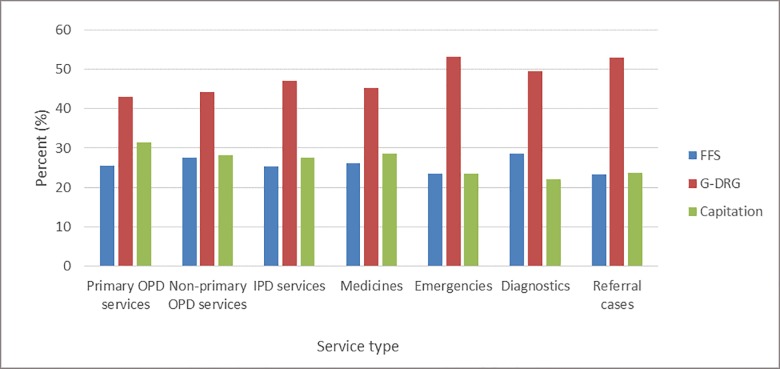
Provider preference for payment method by type of service.Results of the chi-square test showed that healthcare providers’ preference for payment method differed significantly (p<0.001) across all the different types of health care services by region of residence (Table 3). The results further showed that providers in Ashanti region prefer capitation over G-DRG and fee-for-service payments for primary outpatients’ services (47%), non-primary outpatients’ services (39%) and inpatients services (37%). Health care providers in the Volta region preferred G-DRG (79%) to capitation and fee-for-service payments while those in Central showed no clear preference for any particular payment method.